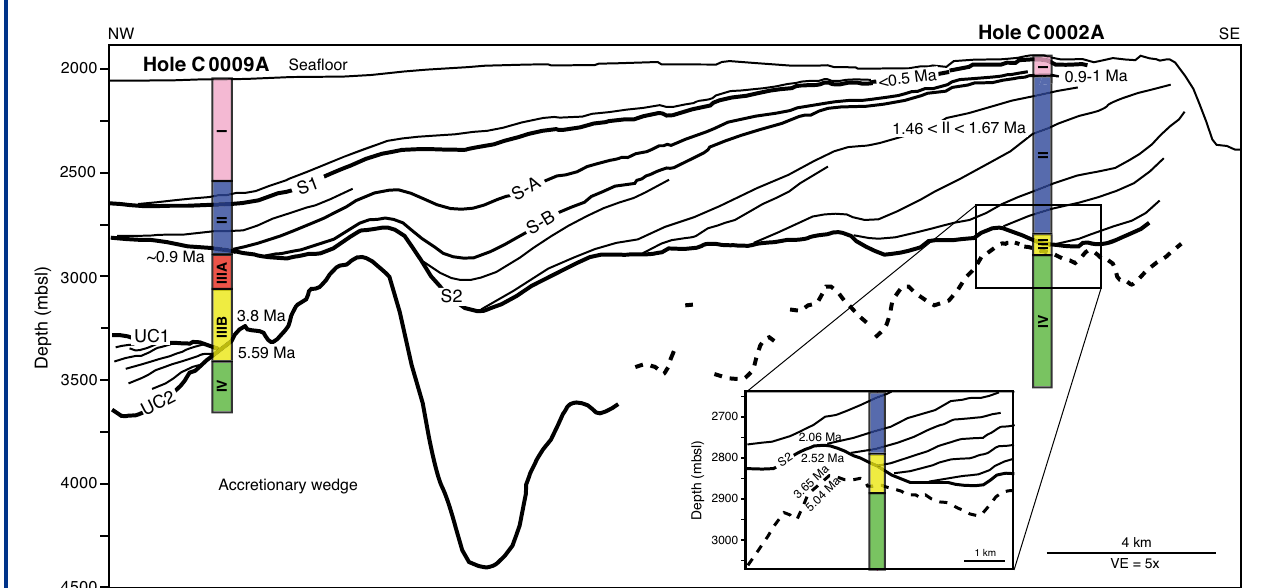
Figure 5. Interpretation of seismic line across the Kumano forearc basin including correlation between Sites C0009 (this expedition) and C0002 (Expeditions 314, 315; Kinoshita et al., 2009b) using seismic and borehole data. Lithologic units are shown at each site. Key regional seismic surfaces are also highlighted (UC1, UC2 = angular unconformities; S1, S2= regional seismic surfaces; S-A, S-B = representative correlatable surfaces within forearc basin stratigraphy). Inset shows detail of Units III-IV at Site C0002. See Saffer et al. (2009, 2010) for further details of seismic stratigraphy and